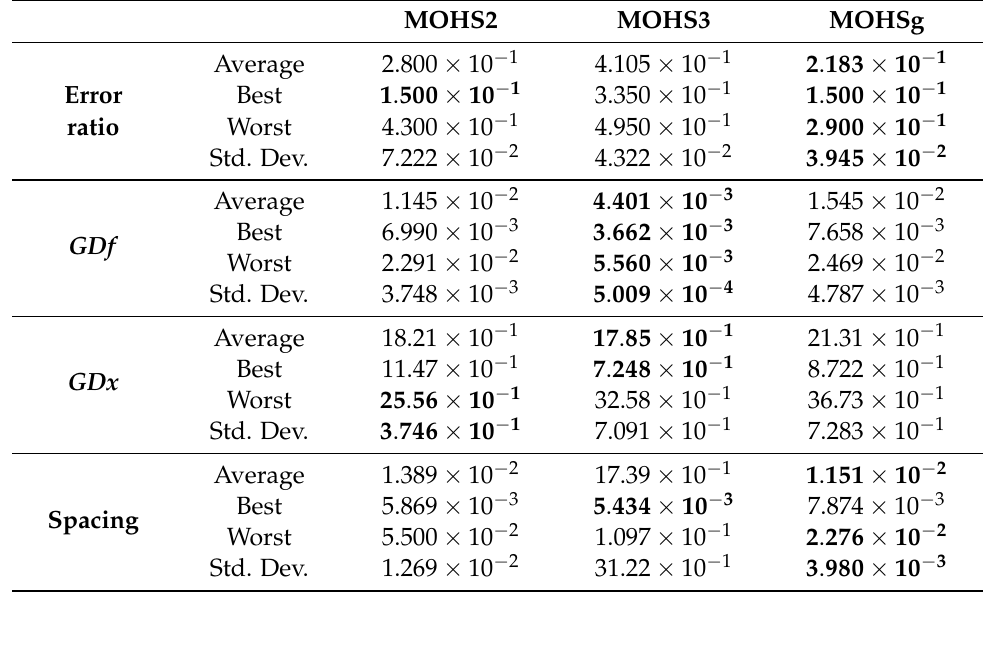
Table 3. Statistic analysis for problem P1.